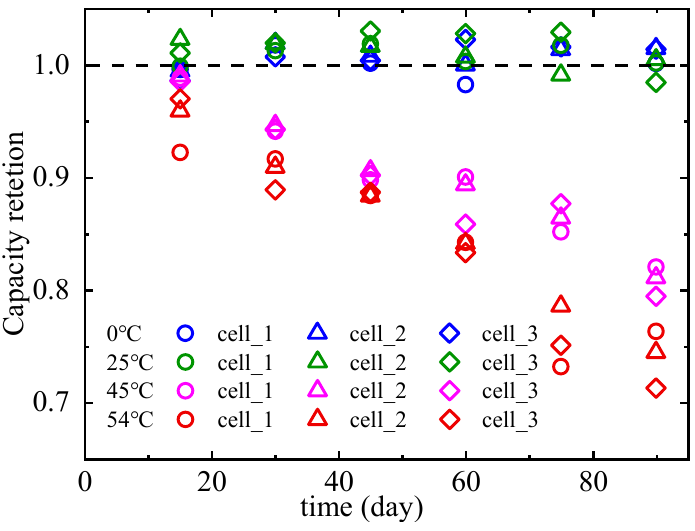
Figure 5. The capacity retention vs. storage time at different temperatures. Different symbols represent three cell samples at the same storage temperature and time.